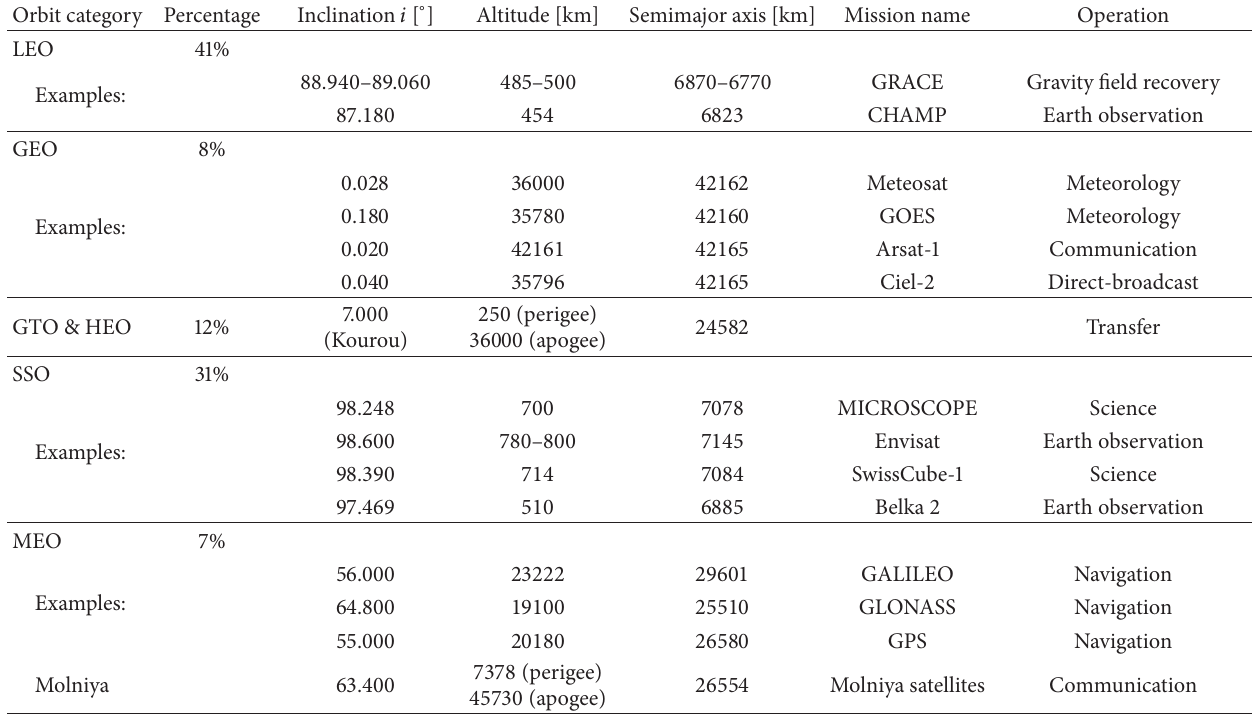
Table 1: Overview of orbit classes including typical orbit parameters and mission